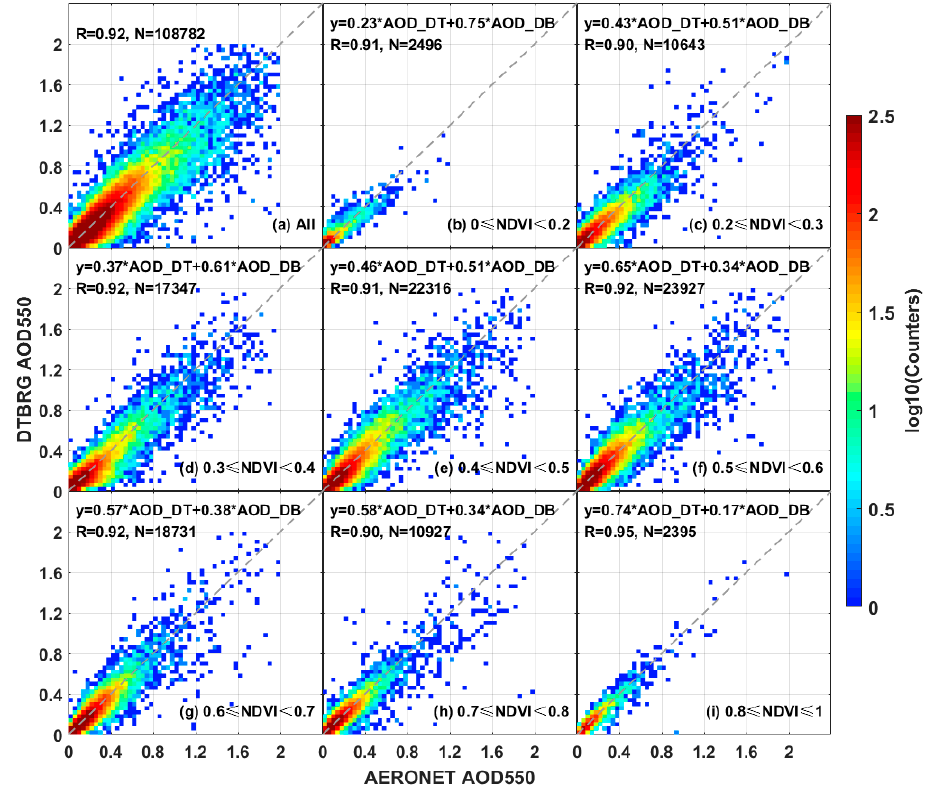
Figure 2. Relationship between AOD DT , AOD DB , and AERONET aerosol optical depth (AOD) within di ff erent normalized di ff erence vegetation index (NDVI) ranges from 2003 to 2016. ( a ) All the coincident observations. ( b – i ) The relationship under di ff erent NDVI bins.